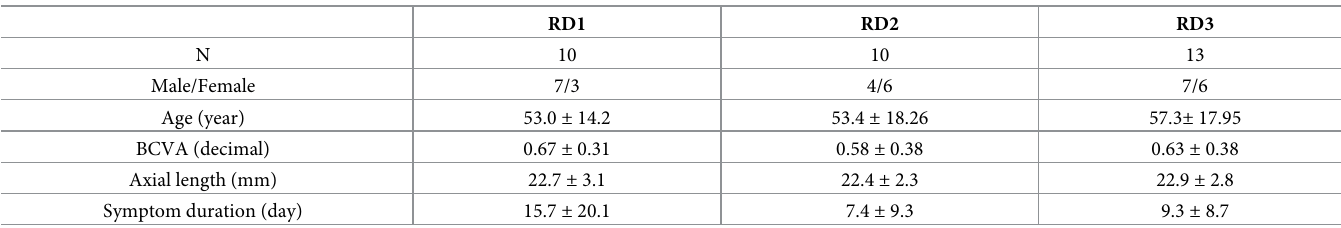
Table 1. Demographic and clinical data of patients.